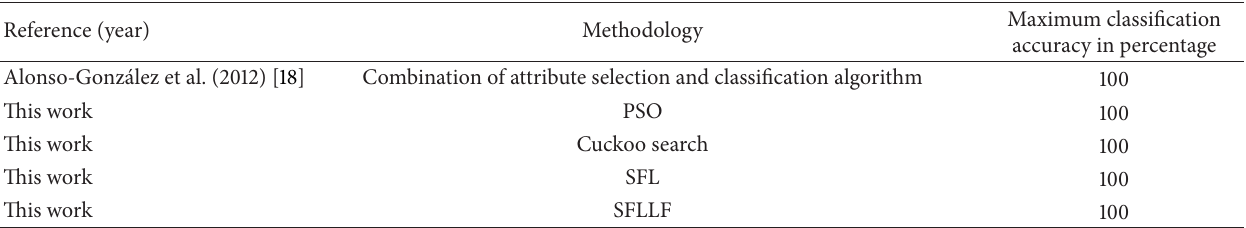
Table 8: Comparison of classification accuracy with other methods for Ovarian Cancer.